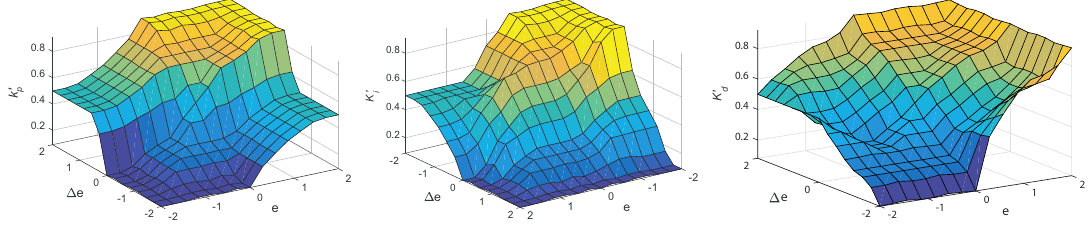
Figure 15. Surface view of the fuzzy supervisor for K (cid:48) p , K (cid:48)